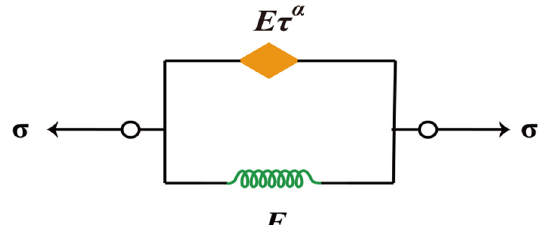
Figure 8: Fractional Kelvin model.